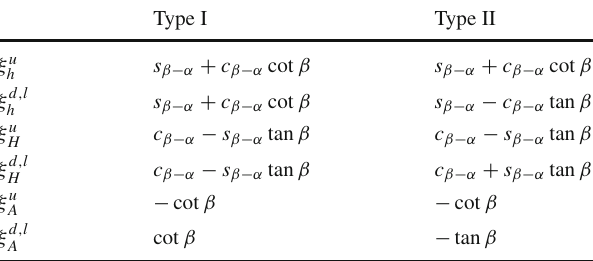
Table 2 Yukawa couplings relative to the SM for h (upper part), H (middle part) and A (lower part) in the 2HDM type I (II) in the middle (right)